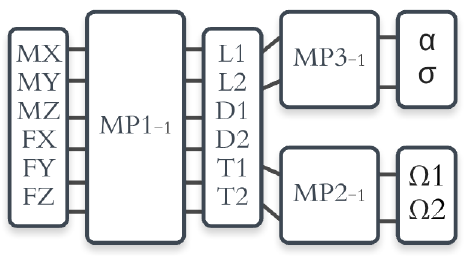
Figure 16. Activation Scheme proposed for the MCR UAV